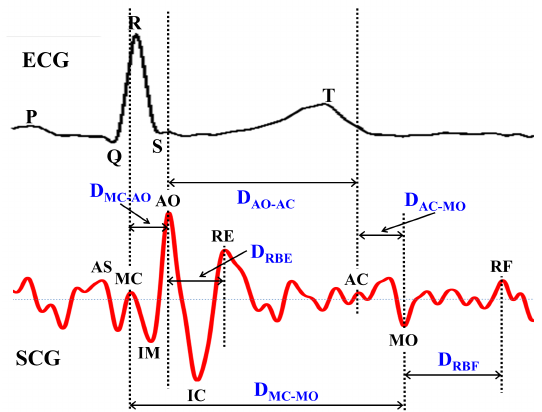
Figure 9. Selection of SCG features for cardiac abnormality